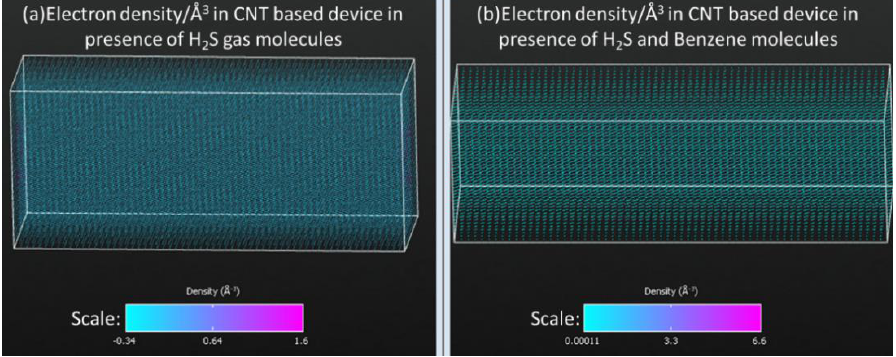
Figure 5. Electron density/Å 3 of simulated device in presence of ( a ) only H 2 S gas molecules; ( b ) both H 2 S and benzene molecules .